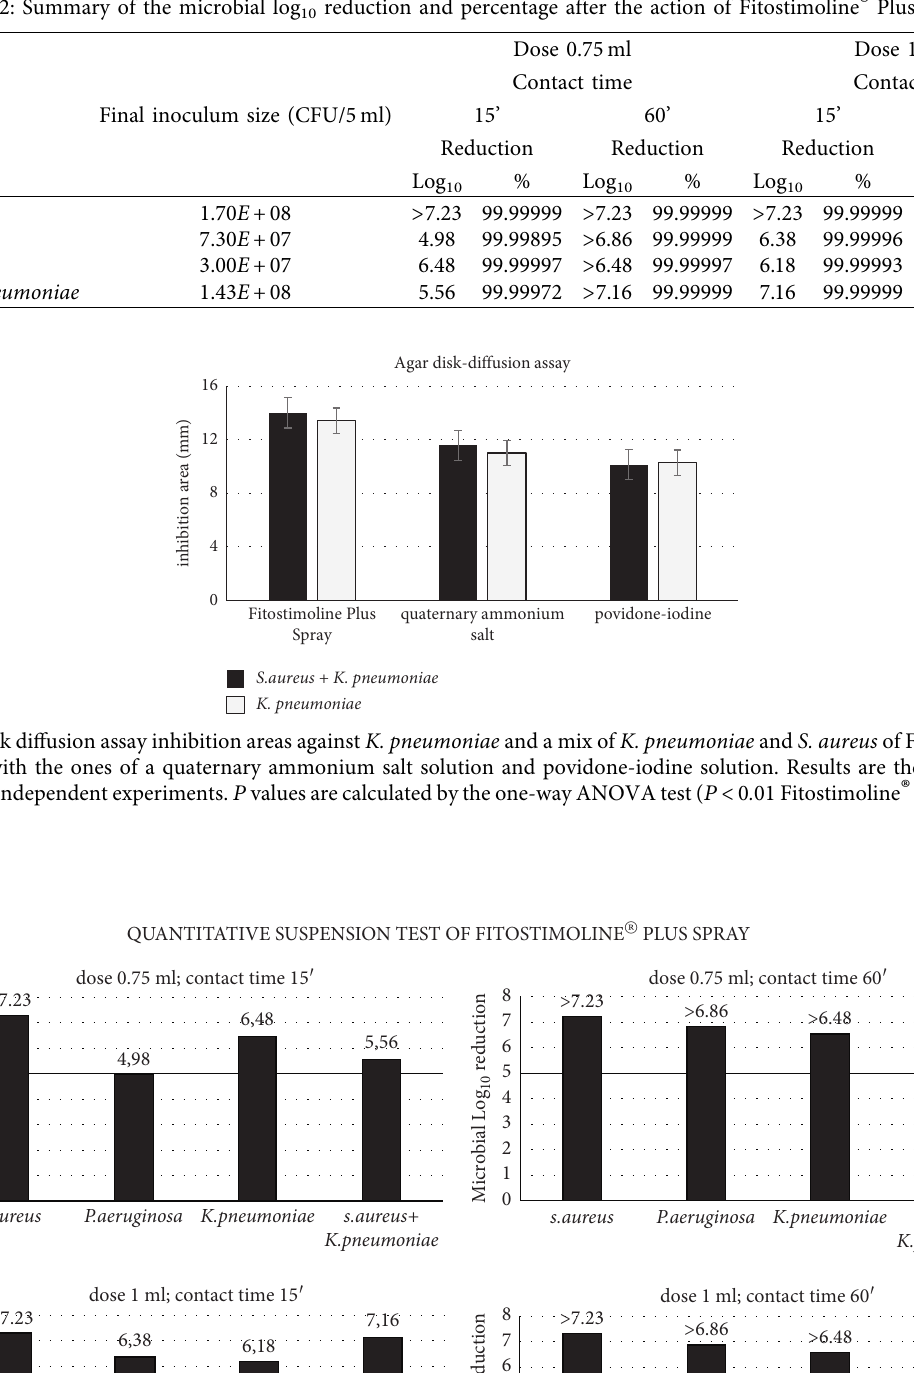
Table 2: Summary of the microbial log